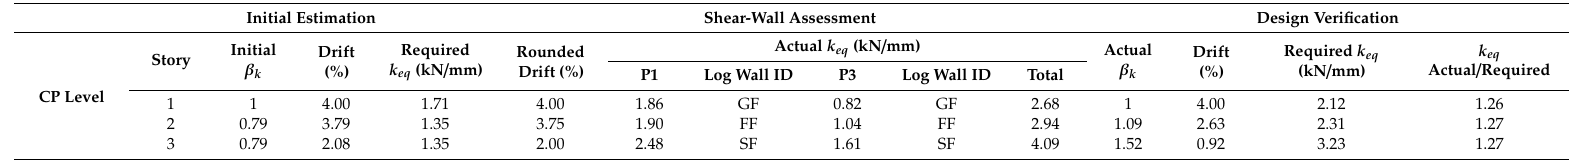
Table 4. Collapse prevention (CP) level analysis (X-direction), accounting for the Elasto-Plastic (EP) shear-wall sti ff nesses.